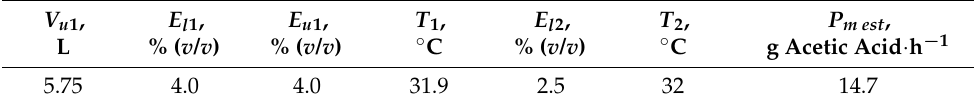
Table 10. Values of the operational variables needed to minimize 𝑃 𝑚 𝑒𝑠𝑡 .